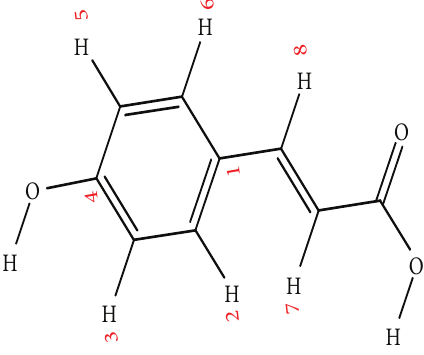
Scheme 1: Structure of P-coumaric